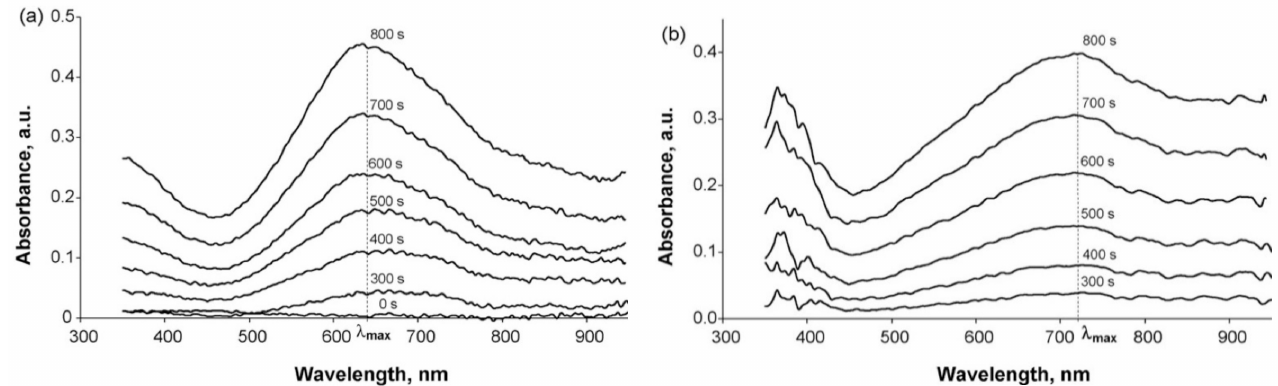
Figure 11. Typical evolution of absorption spectra of polyaniline film during the electrosynthesis at 0.75 V in the presence of: ( a ) flexible-chain polyacid (electrochemical bath: 0.0375 M aniline + 0.075 M PAMPSA; λ max = 640 nm), ( b ) rigid-chain polyacid t-PASA (electrochemical bath: 0.0375 M aniline + 0.0375 M t -PASA; λ max = 720 nm). Reprinted from Electrochimica Acta Volume 53, A.A. Nekrasov et al., “Electrochemical synthesis of polyaniline in the presence of poly(amidosulfonic acid)s with different rigidity of polymer backbone and characterization of the films obtained”,